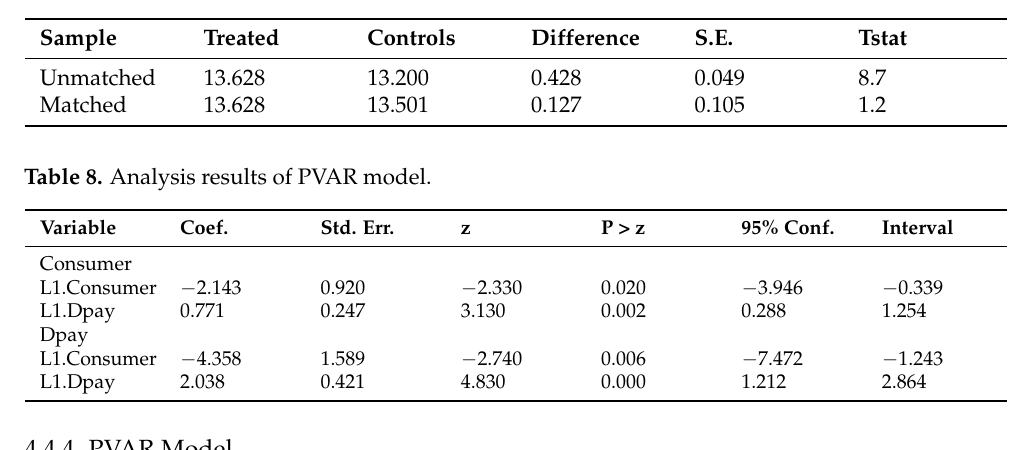
Table 7. PSM analysis results.